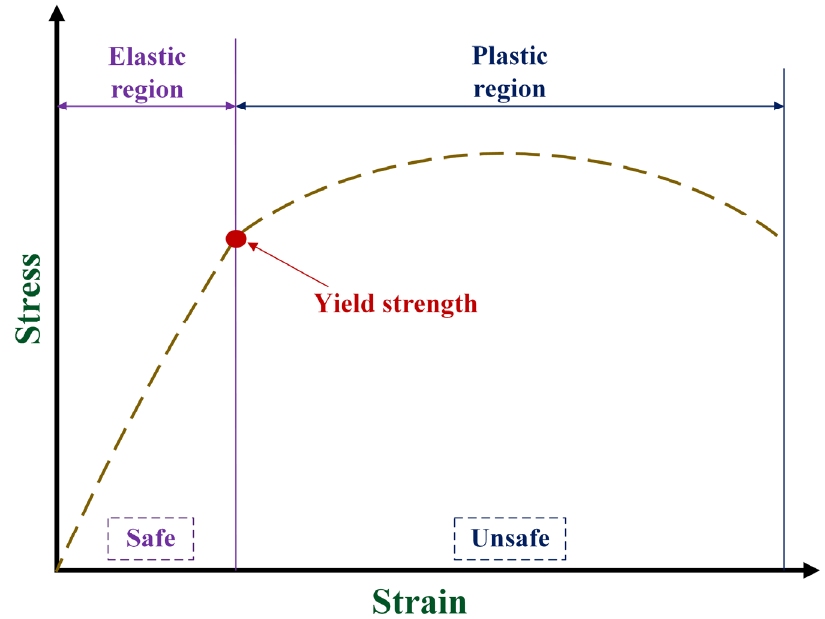
Figure 1. Stress-strain curve [23]. Bearing of total hip prosthesis is indicated to be safe when the von Mises stress does not exceed the yield strength, which indicates that it is still in the elastic region of stress-strain curve.